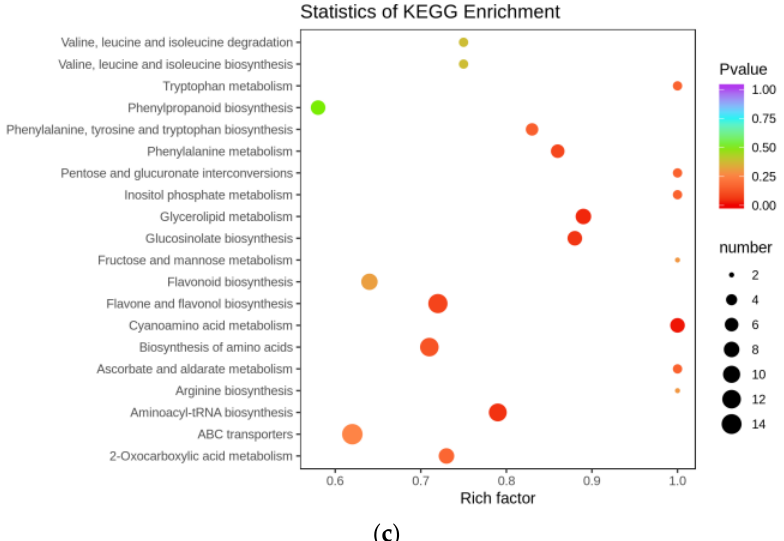
Figure 10. KEGG enrichment map of differential metabolites. ( a ) mRO vs. mLO; ( b ) mRO vs. mSO; ( c ) mSO vs. mLO. The horizontal coordinate indicates the rich factor of each pathway, the vertical coordinate is the pathway name, and the dot color is the p value; the redder it is, the more significant the enrichment. The size of the dots represents the number of differential metabolites enriched.